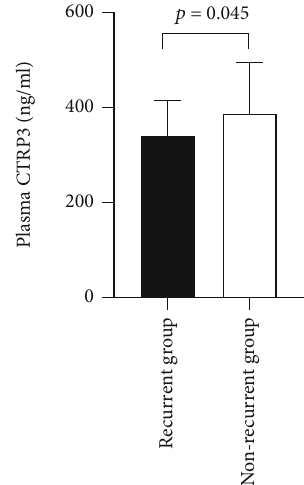
Figure 3: Relationship between plasma CTRP3 levels and (short- term 12 months) prognosis of AF ablation.